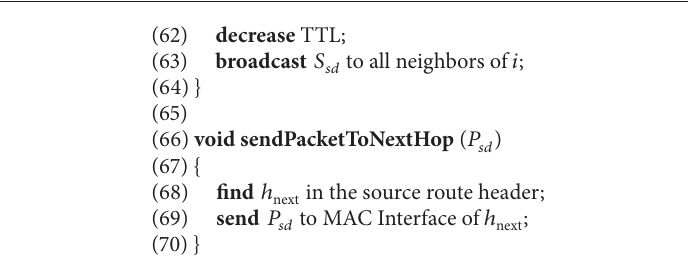
Algorithm 3: Actions taken at the Entrance Floor.